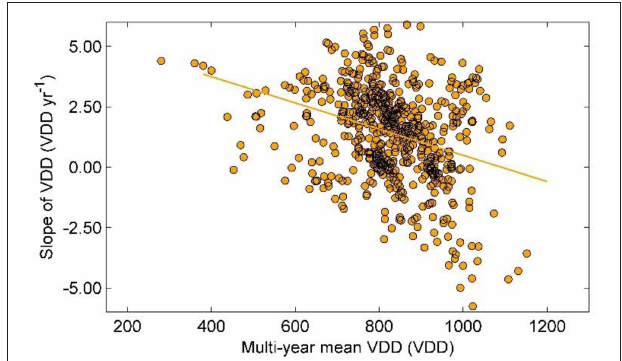
FIGURE 4 | Relationship between multi-year mean vernalization degree days (VDD) and linear trends of VDD during 1975–2009 in croplands of temperate Europe. The orange line is the linear fit for the relationship between multi-year mean VDD (based on the quadratic function in ORCHIDEE_crop) and linear trends of VDD during 1975–2009 ( y = − 0.005 x + 5.9, R 2 = 0.13, p <